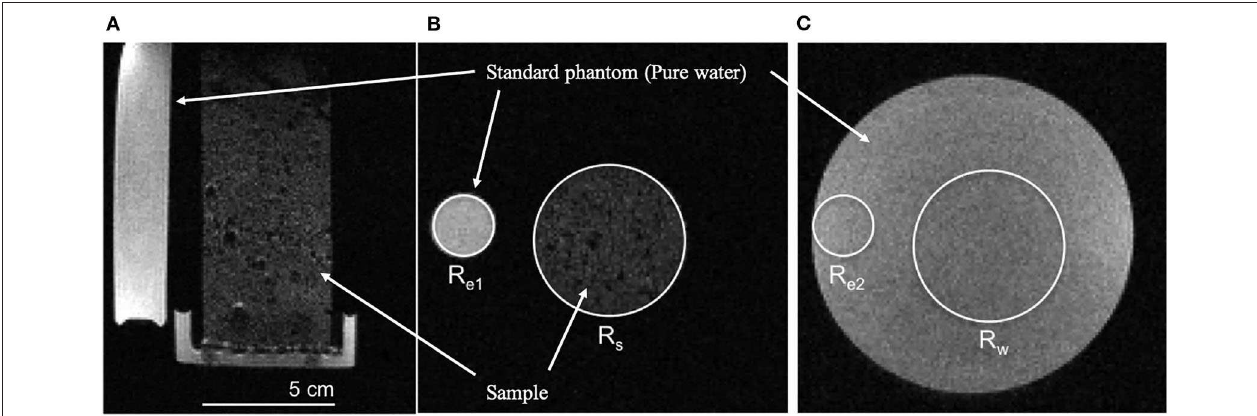
FIGURE 3 | Schematic diagram of the method for calculating volumetric water content from image of MRI. (A) Vertical sectional image of MRI, (B) horizontal sectional image of MRI, and (C) standard phantom filled with pure water only. R s , region of interest of measuring water content of wet snow sample; R e 1 , region of interest of standard phantom neighbor of wet snow sample; R w , same region of interest as R s in standard phantom; and R e 2 , same region of interest as R e 2 in standard